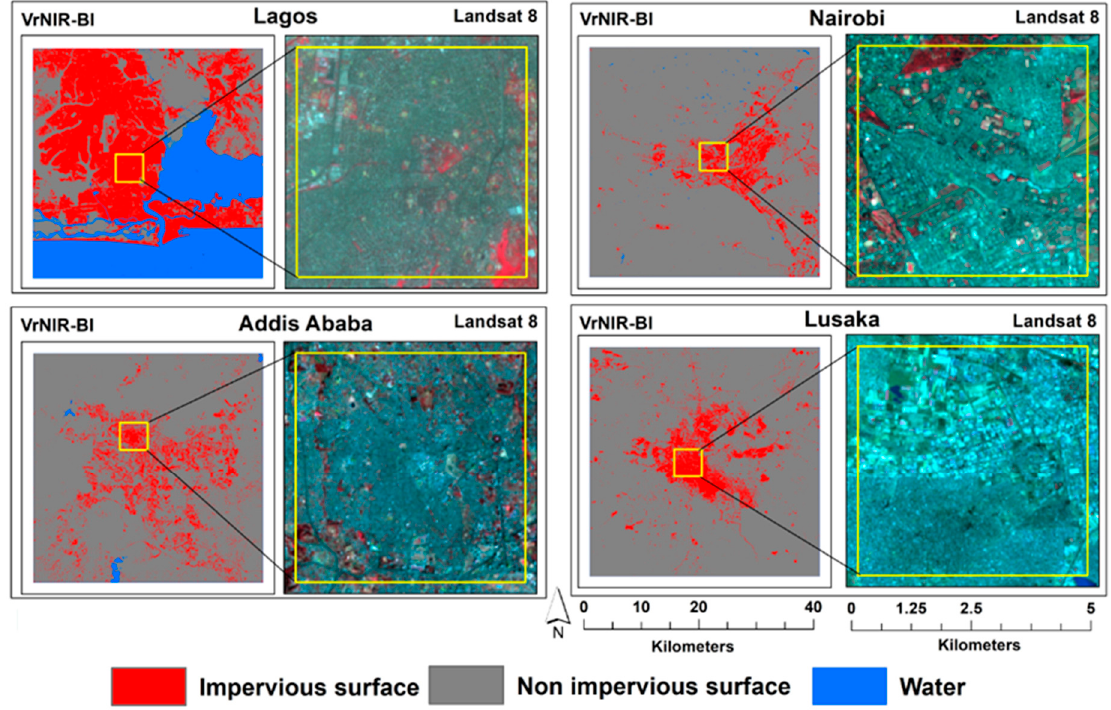
Figure 2. Zoomed-in sample of visible red and NIR-based built-up index (VrNIR-BI) and Landsat 8 imagery in each study area.